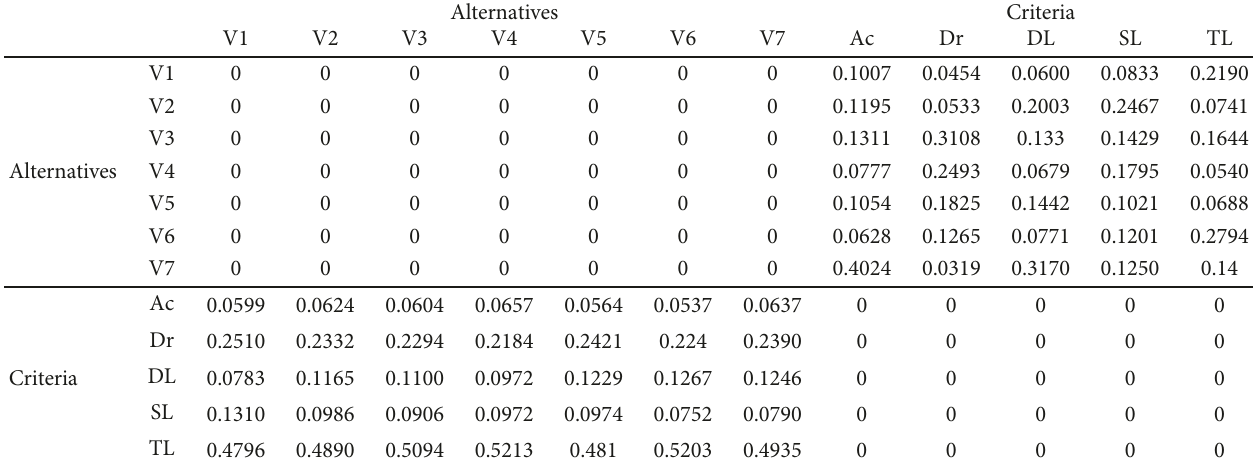
Table 5: Unweighted supermatrix.